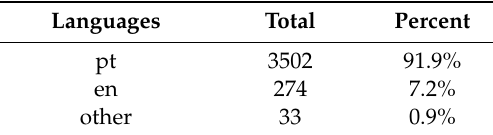
Table A43. Primary languages (pt).